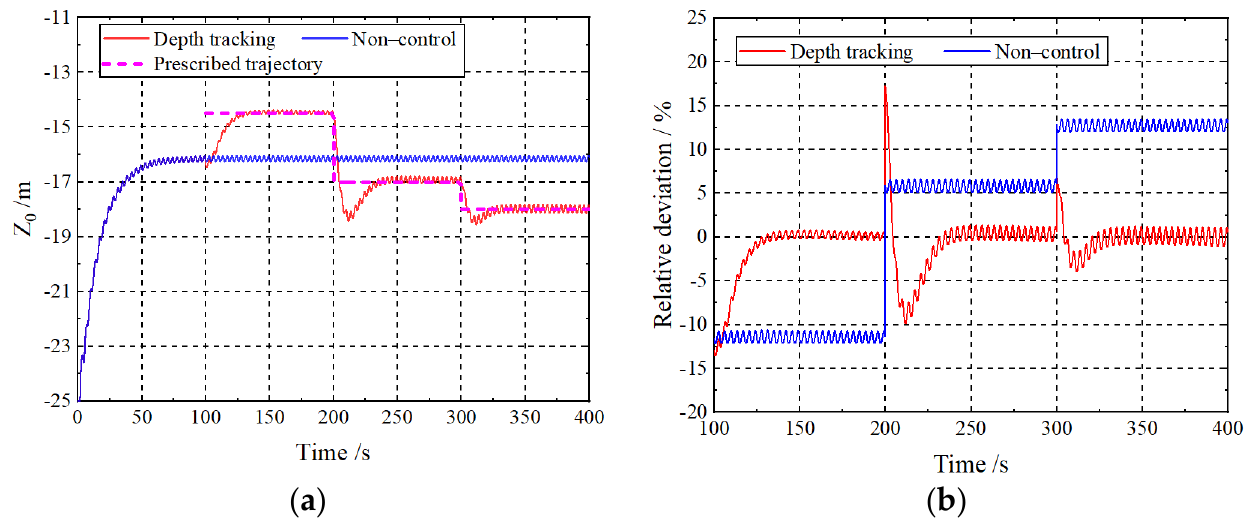
Figure 9. Time history of vertical trajectory of the towed vehicle: ( a ) instantaneous vertical trajectory; ( b ) relative deviation between the instantaneous vertical trajectory and the prescribed one.